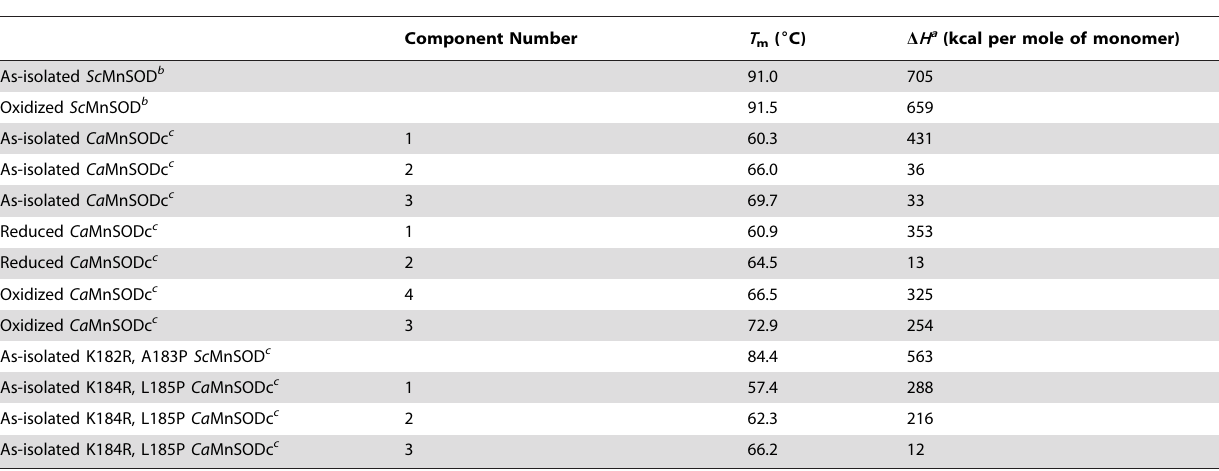
Table 2. Thermodynamic Parameters for Unfolding of Yeast MnSODs.